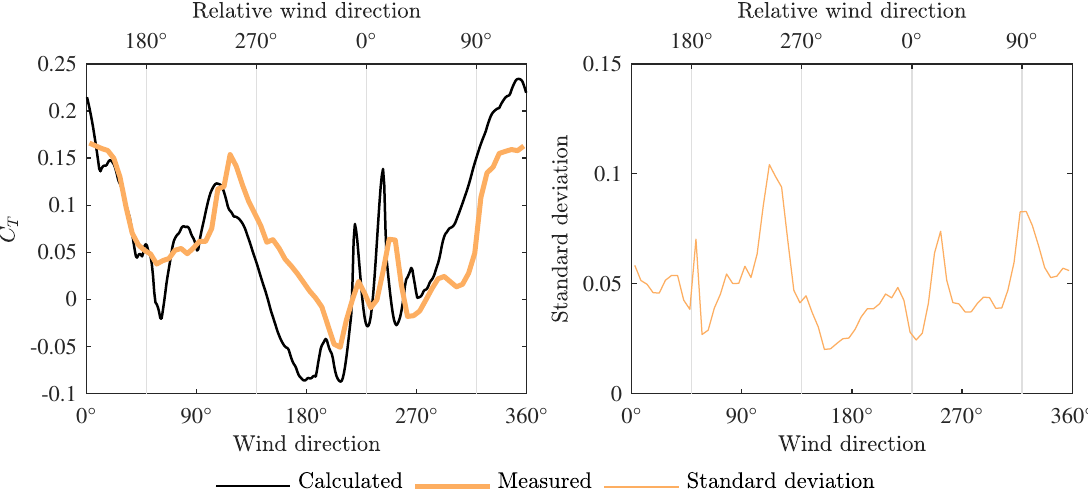
Figure 9. Left : Comparison of measured and calculated torque in the tangential direction, here illustrated as the corresponding tangential forces coefficient at the blade. Right : Standard deviation of the